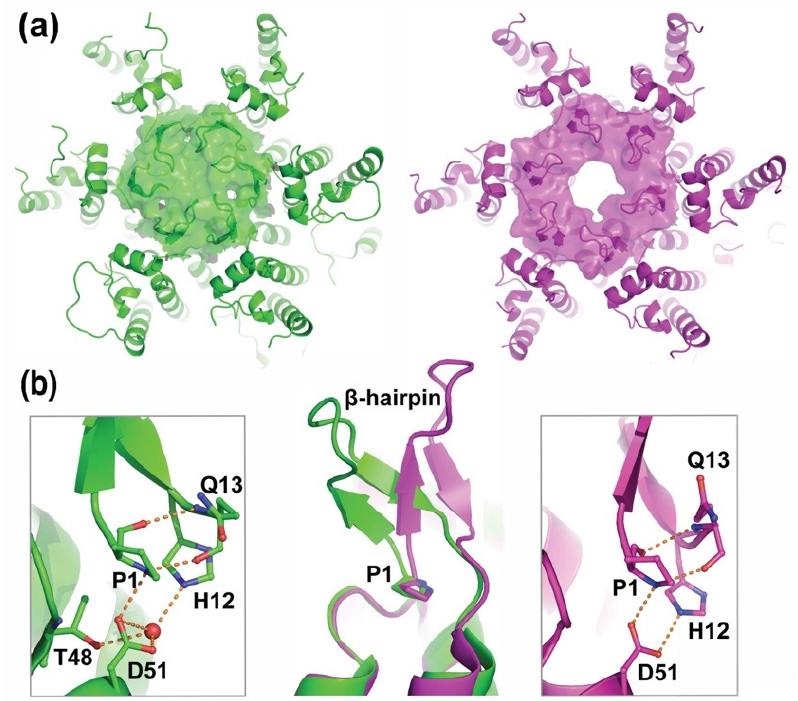
Figure 3. The HIV-1 CA β -hairpin Adopts Different Conformations that Open and Close the Central CA Hexamer Pore. ( a ) Space-filling model showing the central pore of the CA hexamer in its closed (green, PDB: 5TSX) and open (magenta, PDB: 5HGL) configurations. ( b ) Positions of the β -hairpin (middle panel) in the closed (green, PDB: 4B4N) and open (magenta, PDB: 5HGL) conformations. Note the rotation about CA Pro1 (P1, sticks). Expanded panels show the Pro1 polar interactions (dashed orange lines) and surrounding CA residues in the closed (green, left panel, PDB: 2GON) and open (magenta, right panel, PDB: 5HGL) conformations. The red sphere depicts a water molecule.